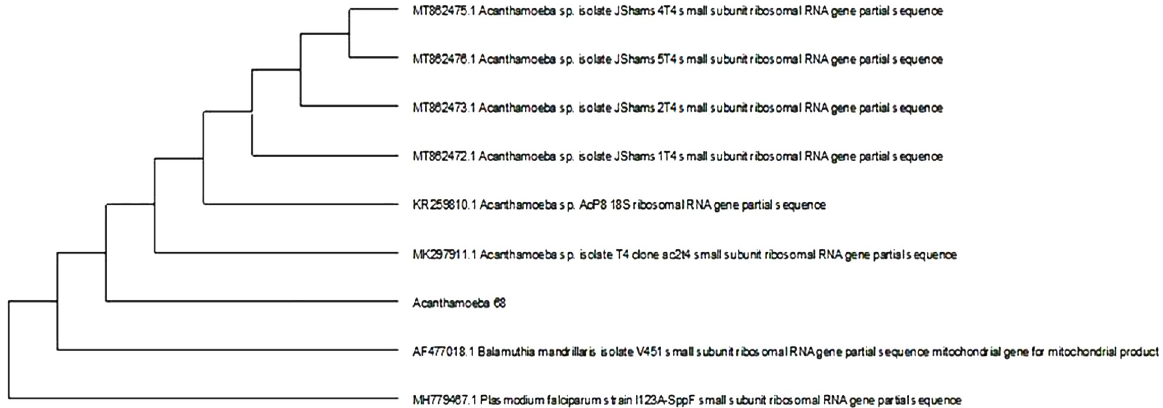
Fig 6. Phylogenetic tree derived by aligning the 18s rDNA sequence of the strain isolate (68). The results obtained showed that its 18s rDNA sequence shared considerable homology with A . polyphaga .